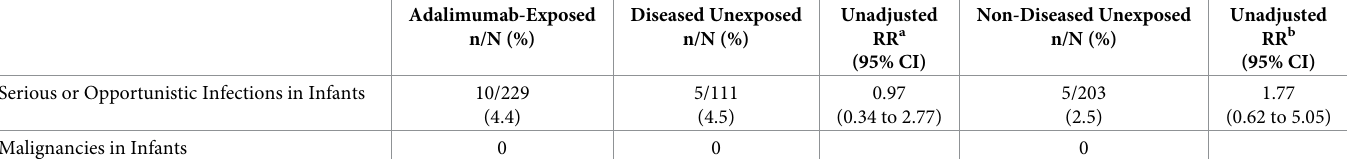
Table 6. Serious or opportunistic infections and malignancies up to one year of age in infants born to adalimumab compared to women not exposed, 2004 to